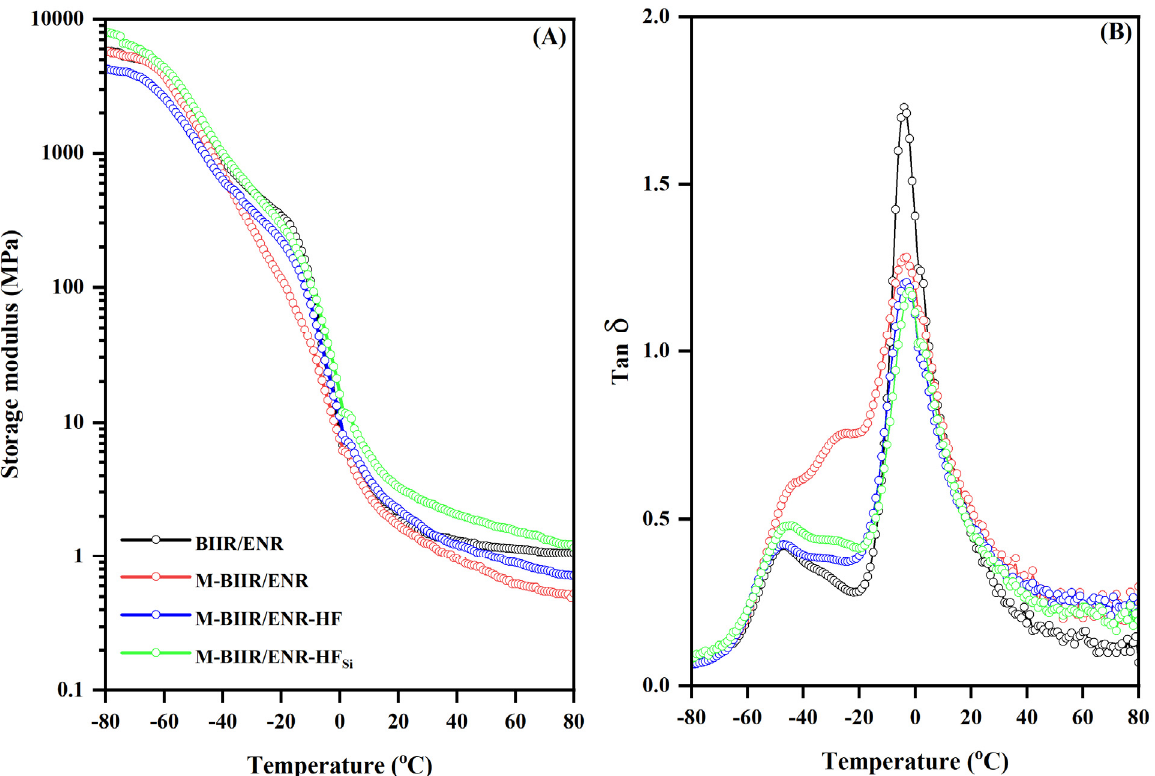
Figure 9. Relationship of the storage modulus ( A ) and Tan δ ( B ) with temperature of unmodified BIIR and the M-BIIR/ENR composites filled with CNT/CB with and without the addition of TESPT.